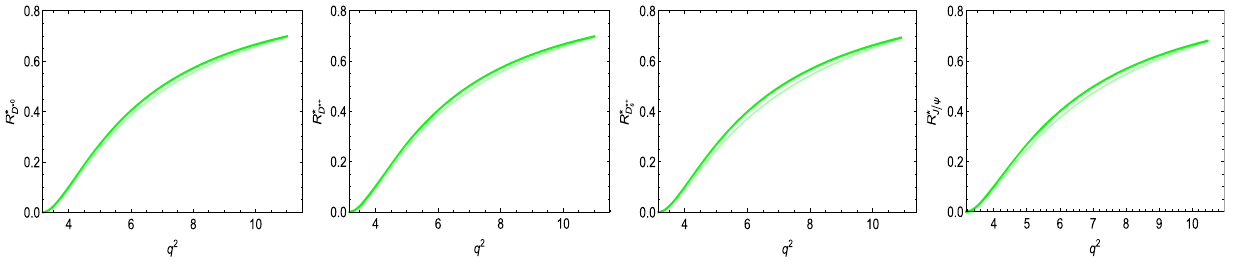
Fig. 5 The ratio of branching ratio R ∗ ( L ) longitudinal observable R ∗ L